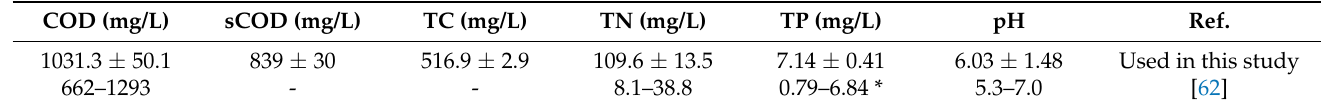
Table 2. Characterization of the synthetic influent and similar real dairy